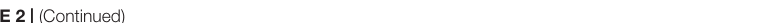
FIGURE 2 | (Continued) expression of osteogenic differentiation-related factor with different concentrations of EPI-sEV; the normalized data represented mean ± SD. un-sEV: sEVs derived from untreated BMSCs; EPI-sEV20: 20 g/L EPI-sEV, EPI-sEV50: 50 g/L EPI-sEV, and EPI-sEV100: 100 g/L EPI-sEV. (F) The immunofluorescence results of ALP and RUNX2 with different concentrations of EPI-sEV. un-sEV: sEVs derived from untreated BMSCs; EPI-sEV20: 20 g/L EPI-sEV, EPI-sEV50: 50 g/L EPI-sEV, and EPI-sEV100: 100 g/L EPI-sEV. (G) ARS staining with different concentrations of EPI-sEV. A: Un-sEV group, B: EPI-sEV20, C: EPI-sEV50, and D: EPI-sEV100. (H) ALP staining with different concentrations of EPI-sEV. A: Un-sEV group (sEVs derived from untreated BMSCs), B: EPI-sEV20 (20 g/L EPI-sEV), C: